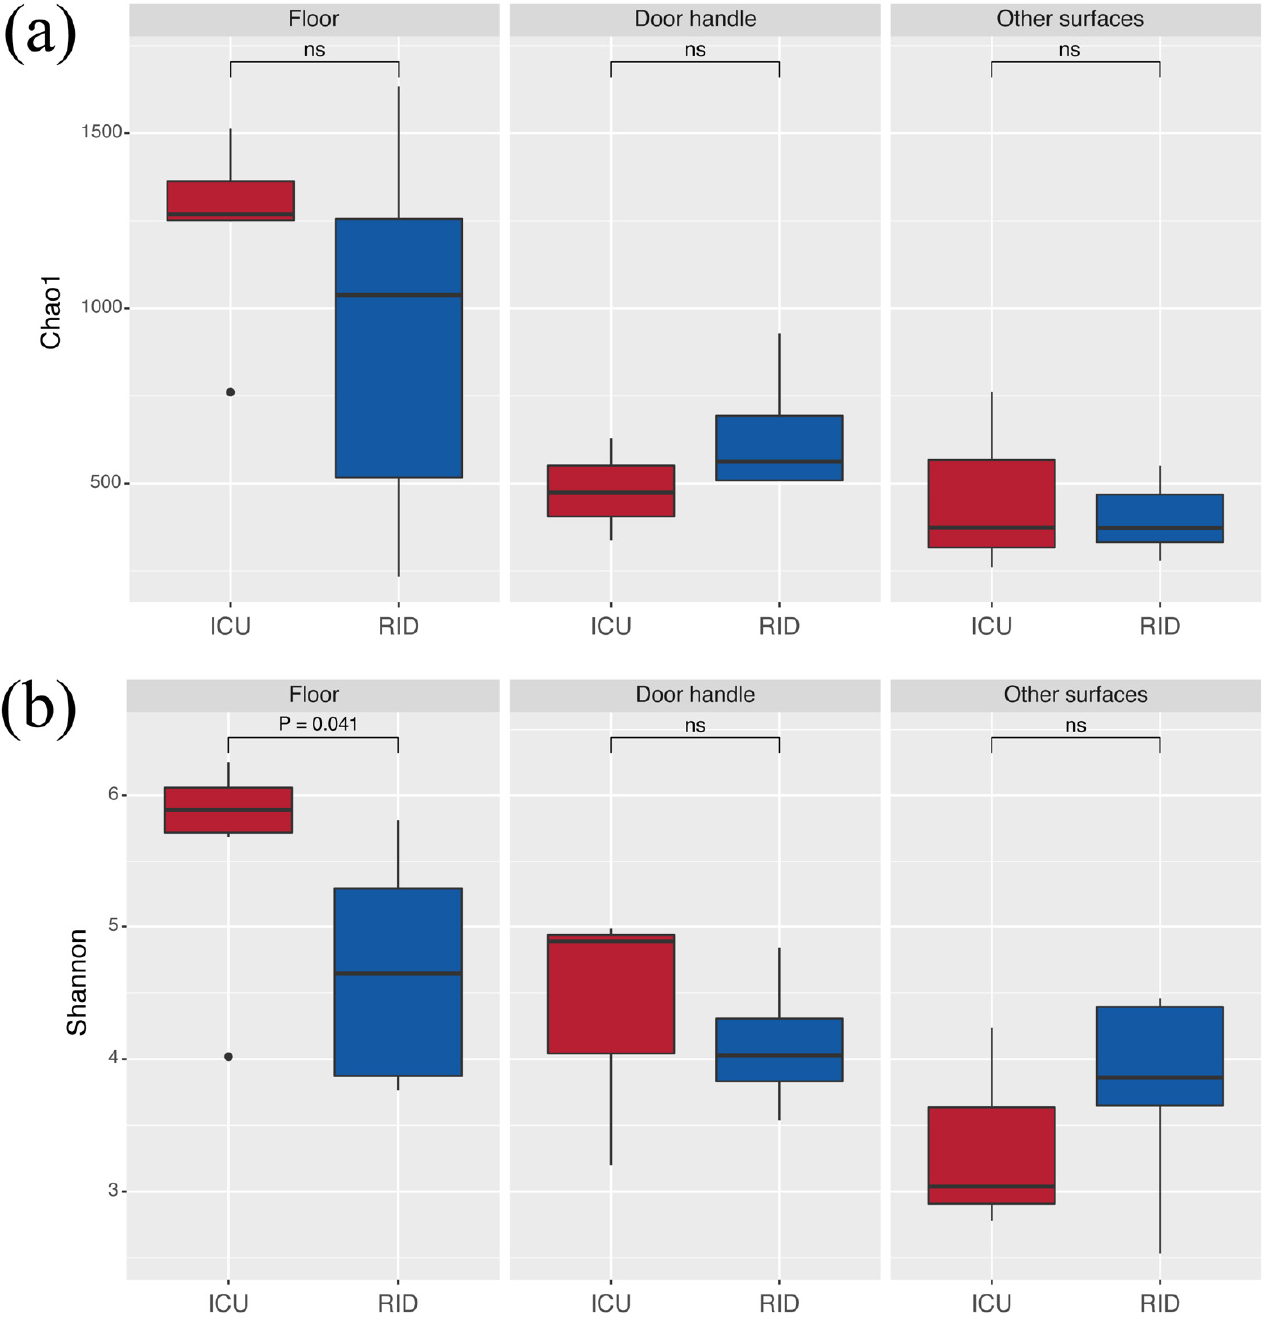
Figure 1. Relative taxonomic distribution at the family level: ( a ) by department; ( b ) by department and surface type. Fam- ilies with a proportion of <2% are listed as “Other”. ICU—Intensive Care Unit; RID—Respiratory Infections Department.